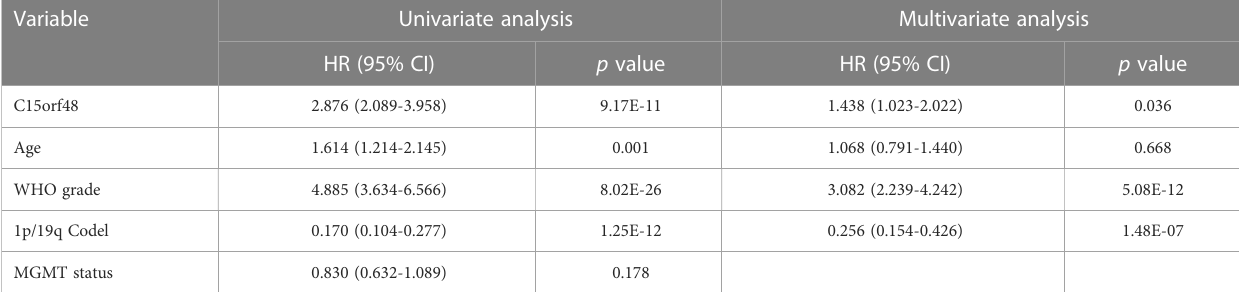
TABLE 2 Univariate and multivariate analyzes of OS prognostic parameters in the CGGA